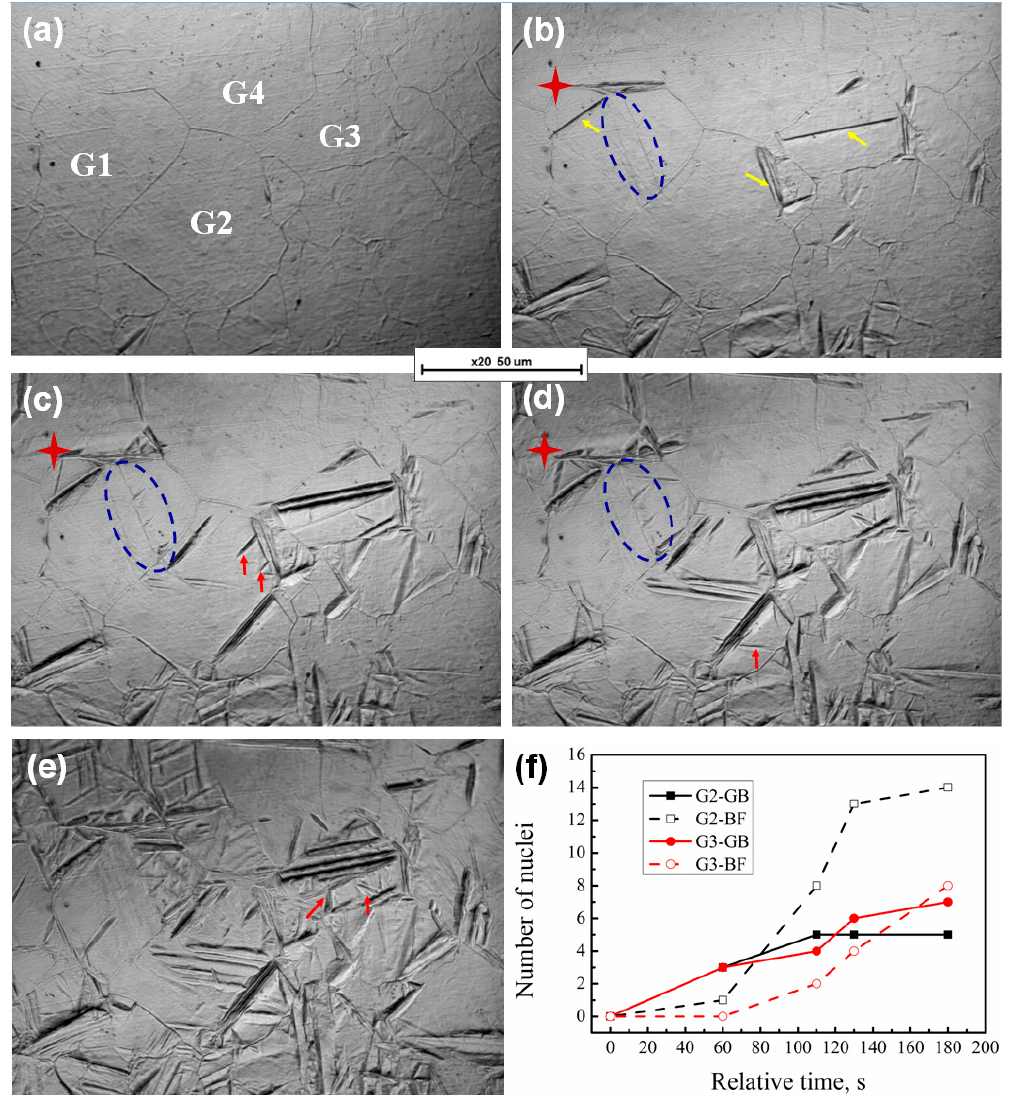
Figure 2. In situ laser scanning confocal microscopy (LSCM) of carbide-bearing bainite: ( a ) 0 s; ( b ) 60 s; ( c ) 110 s; ( d ) 130 s; ( e ) 180 s. ( f ) Relationship between relative time and number of nucleation sites. Note—GB: Grain boundary of original austenite; BF: Previously formed bainitic ferrite; yellow arrows: nucleation sites at GB; red stars and red arrows: nucleation sites on BF (the former represent nucleation sites on the previously formed BF tip); blue circle: nucleation site on BF that appears on a plane where a three-dimensional space of bainitic ferrite forms.